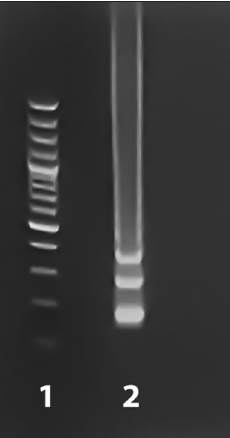
Figure-1: Agarose gel electrophoresis under LED illuminator used to observe the band of loop-mediated isothermal amplification (LAMP) products, where a positive result of LAMP shows a ladder-like band pattern. Lane 1, 100 bp Plus DNA Ladder; Lane 2, LAMP-positive sample.